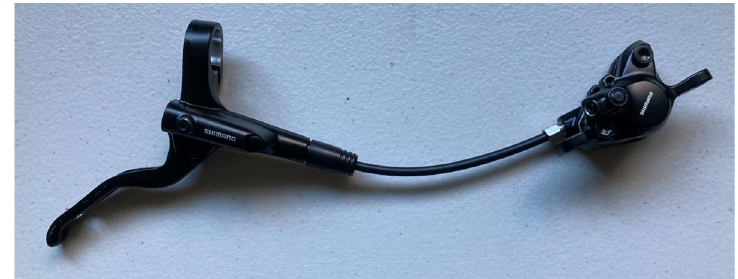
Figure A5. Shortened brake system to eliminate potential hysteresis due to trapped air and hose expansion. A shortened brake system also decreases the potential hysteresis due to hose expan- sion. At high lever force, the hose can expand, which increases the system volume and decreases the output force. As the lever is released, the line pressure stays elevated as the hose contracts, and the system volume decreases, but, as before, there was no change in the results. Another culprit may be viscous drag creating a time delay in pressure response. As the fluid flows through the hose, it takes time to flow, so the decrease in pressure is not instantaneous. To test this, different lever application speeds were investigated, with no change in the results. Another form of drag in the system comes from the piston seals. As the pistons retract, the drag from the seals can cause a time delay in the pressure decrease, potentially causing the hysteresis seen. This was tested by shimming the system so that there was no piston displacement; however, there was still no change in the results. The details of the final iteration of the prototype are available in Section 4.2.